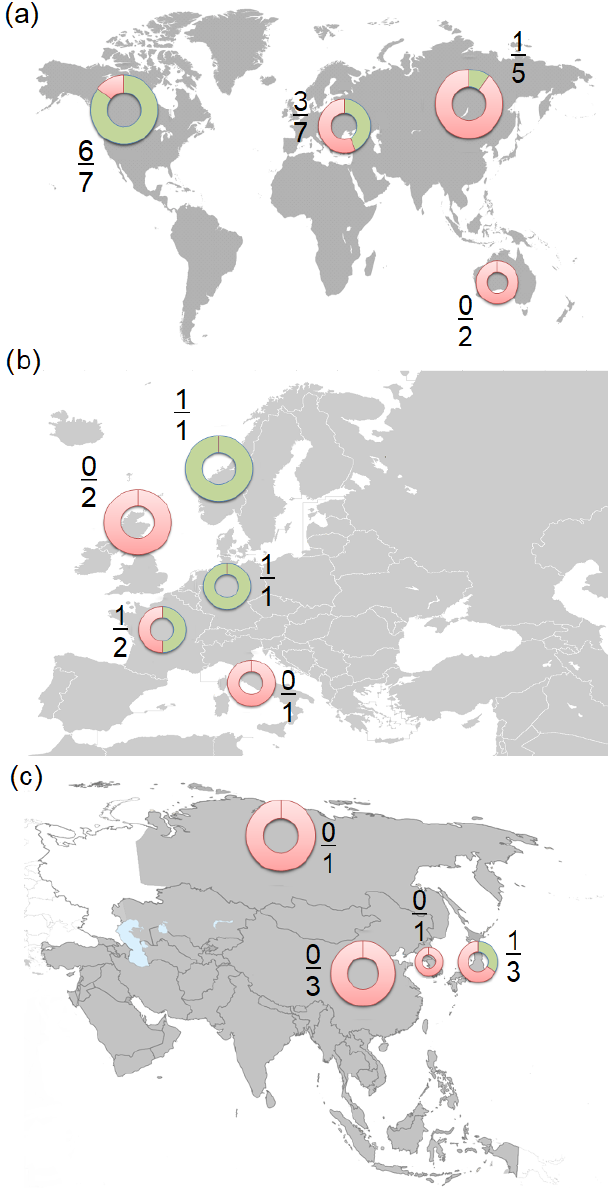
Figure 1. Geographical map with the number of models obtained from each region: (a) worldwide; (b) Europe (EC-Earth is only in- cluded in the worldwide view because it is developed as a consor- tium of 16 European countries); and (c) Asia. Green shading and the fractions represent the obtained models from the